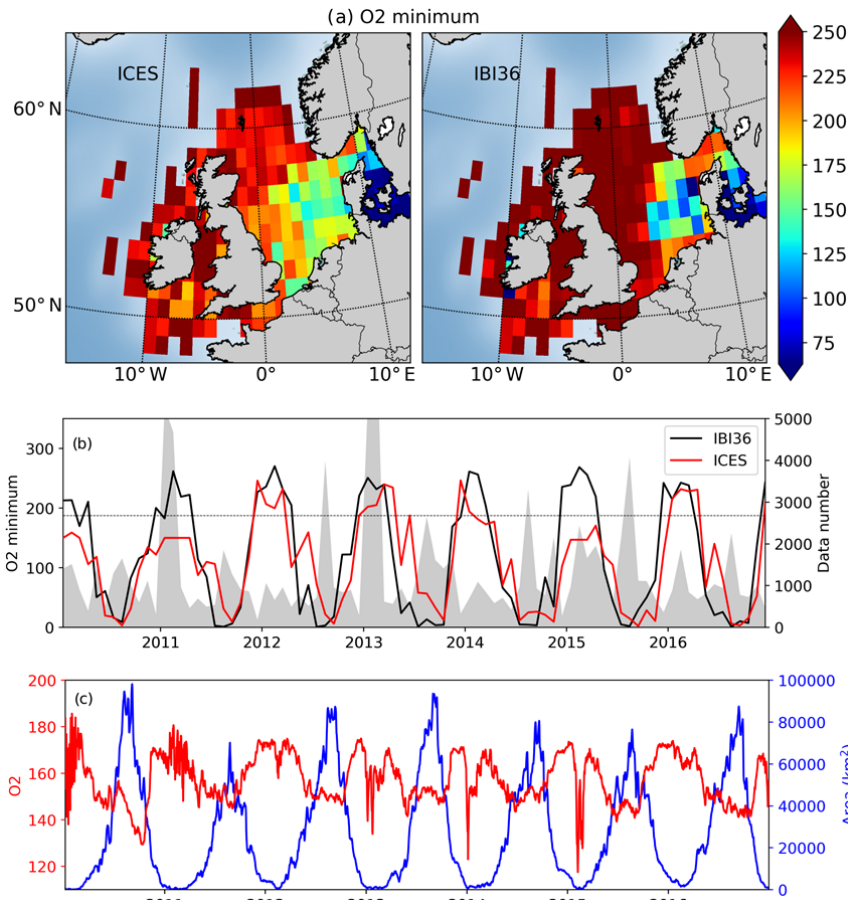
Figure 11. (a) Minimum oxygen (µmolL − 1 ) in ICES data (left) and IBI36 collocated to ICES (right) between 2010 and 2016. (b) Time series of minimum oxygen (µmolL − 1 ) in ICES data (red) and IBI36 IBI36 collocated to ICES (black). The deficiency threshold of oxygen (6mgL − 1 or 187.5µmolL − 1 ) is represented by the dashed line. The number of available data in ICES is added to the right axis (area plot in gray). (c) Surface area (in km 2 ) vulnerable to oxygen deficiency, i.e. where oxygen decrease is below the deficiency threshold (blue; right axis) and associated mean oxygen concentrations (µmolL − 1 ; red; left axis) using the whole IBI36 simulation (not only IBI36 collocated to ICES). The three subplots are for the continental shelf (bathymetry < =